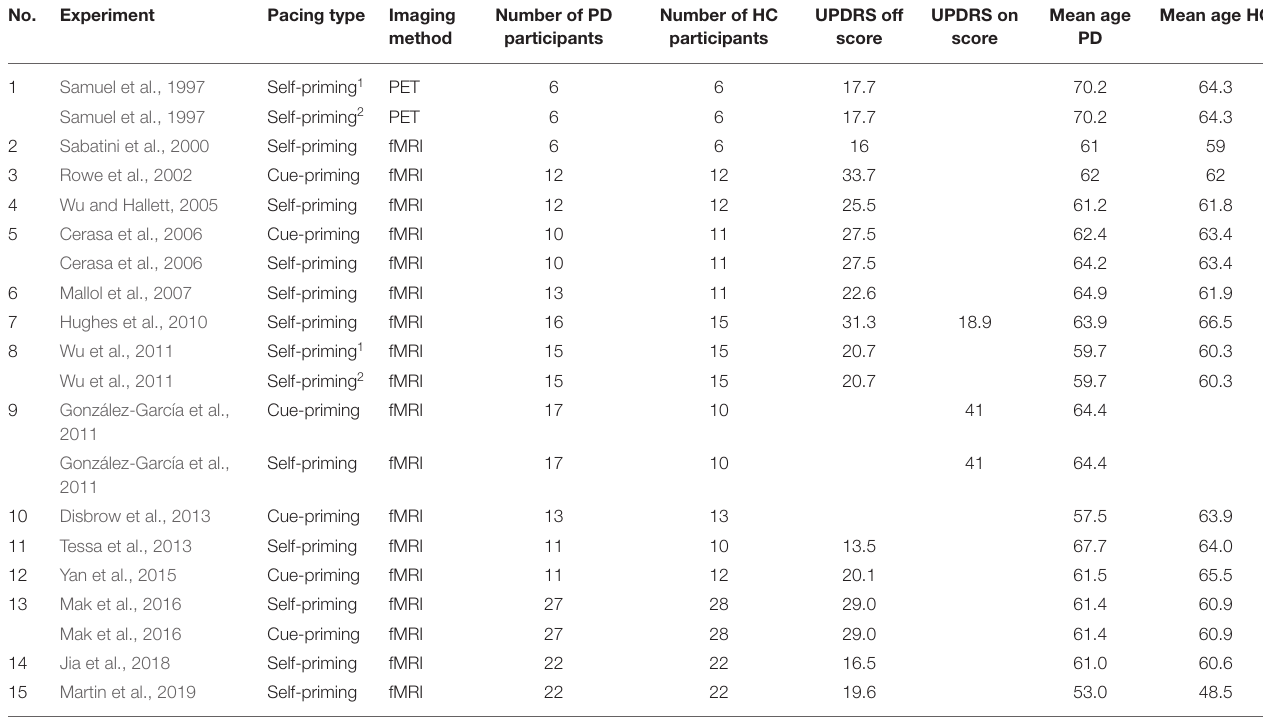
TABLE 1 | Characteristics of the studies included in the